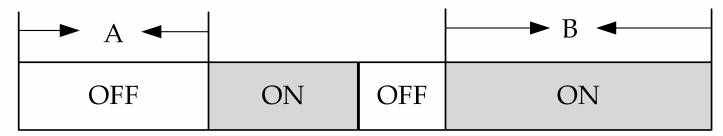
Figure 1. Activity model for primary user